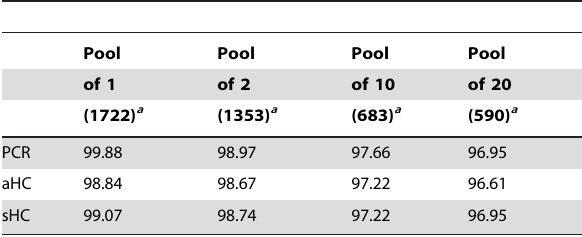
Table 3. HapMap variation detection specificity after duplicate removal.